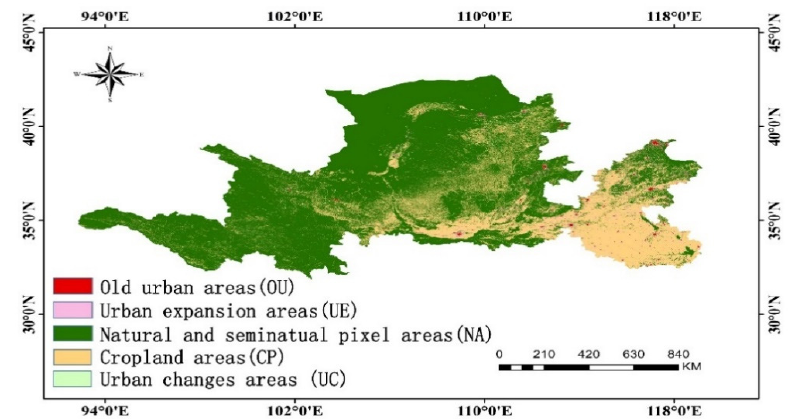
Figure 3. Spatial distribution of land use types in the influence area of the Yellow River Basin in 2015.